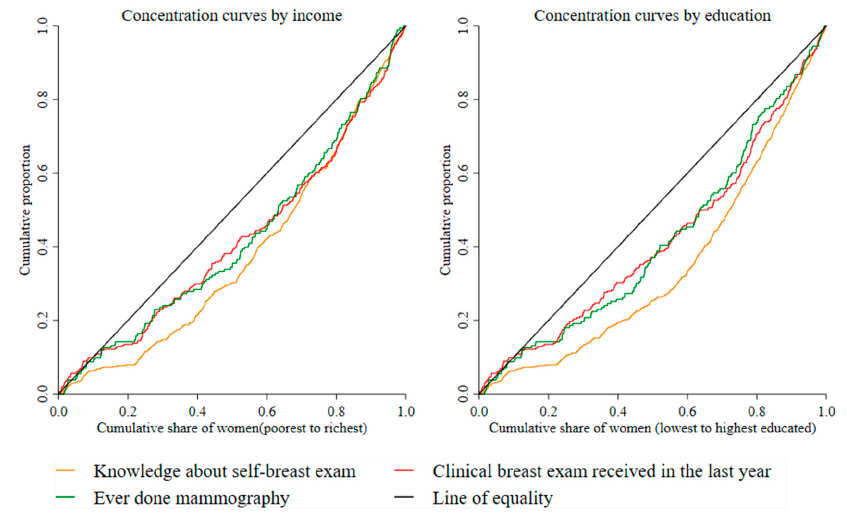
Figure 2. Concentration curves of breast cancer screening uptake by education and income.